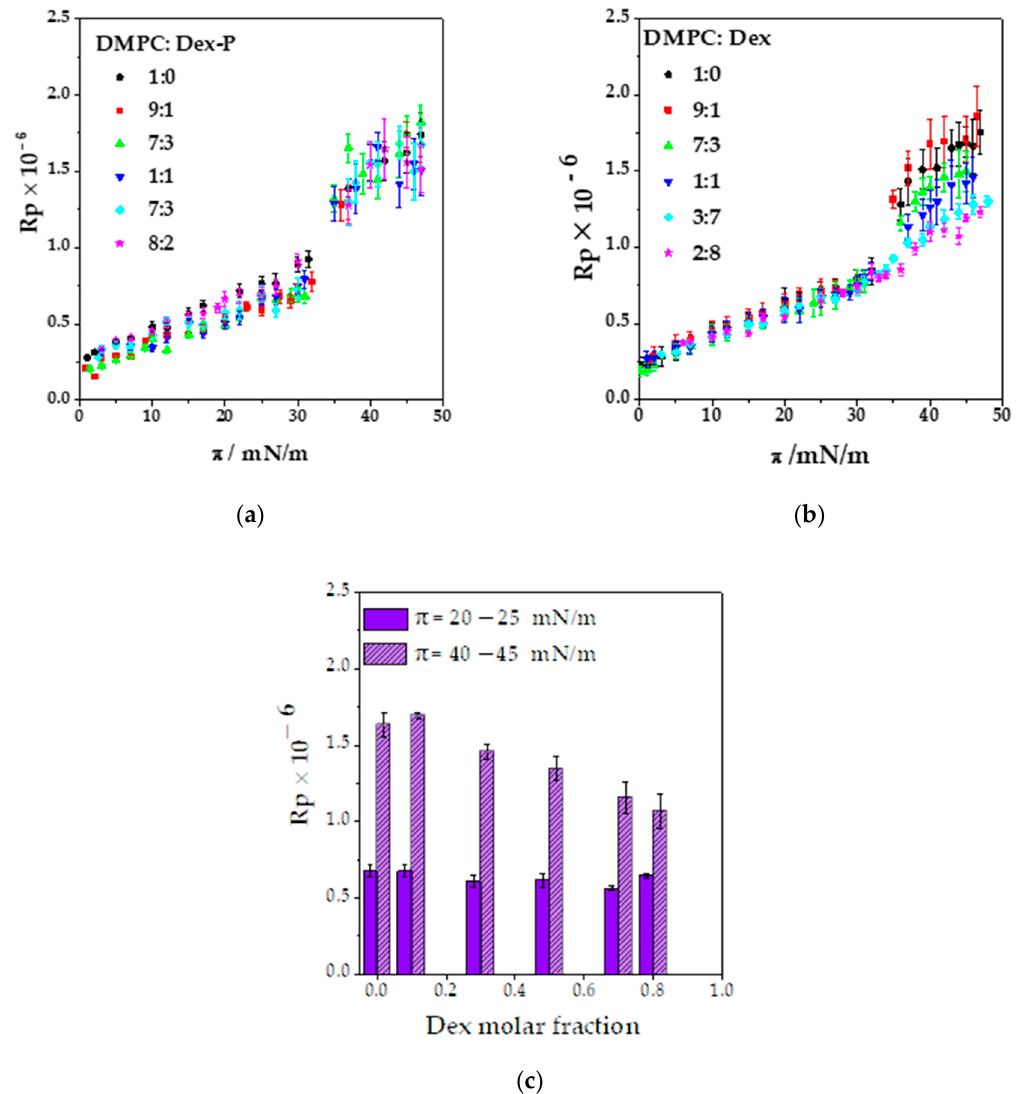
Figure 4. Reflectivity (Rp) as function of the surface pressure for DMPC: X mixture, were X: Dex-P ( a ) or Dex ( b ). DMPC: X molar fraction; 1:0 (black), 9:1 (red), 7:3 (green), 1:1 (blue), 3:7 (cyan) and 2:8 (magenta). ( c ) Average Rp as a function of Dex molar fraction, the average values was obtained for surface pressures in the range of 20–25 mN/m (violet), and 40–45 mN/m (dashed violet). The reflectivity values were obtained from BAM images such as those shown in Figure 3a,b.